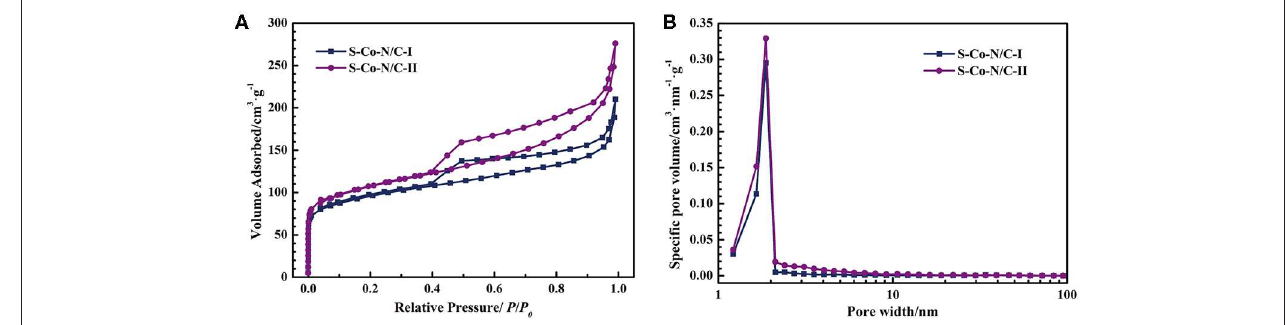
FIGURE 4 | (A) Nitrogen adsorption-desorption curves of the S-Co-N/C, (B) Pore size distribution curves of the S-Co-N/C.